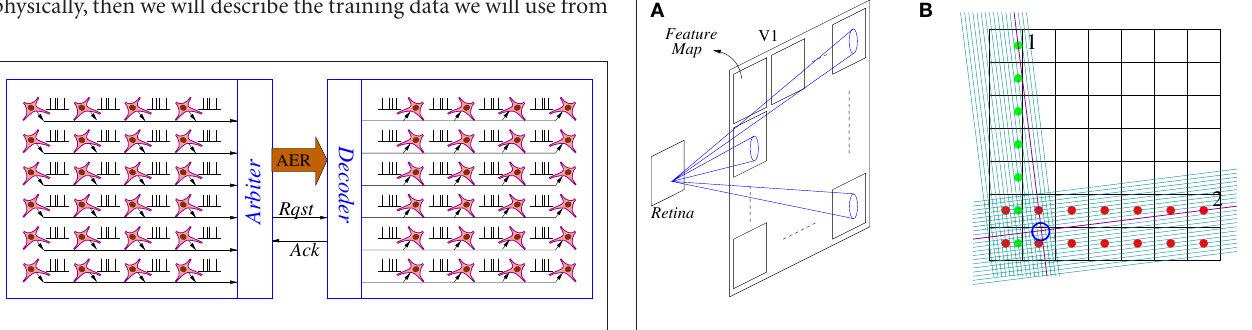
Figure 20 | illustration of Aer point-to-point communication link